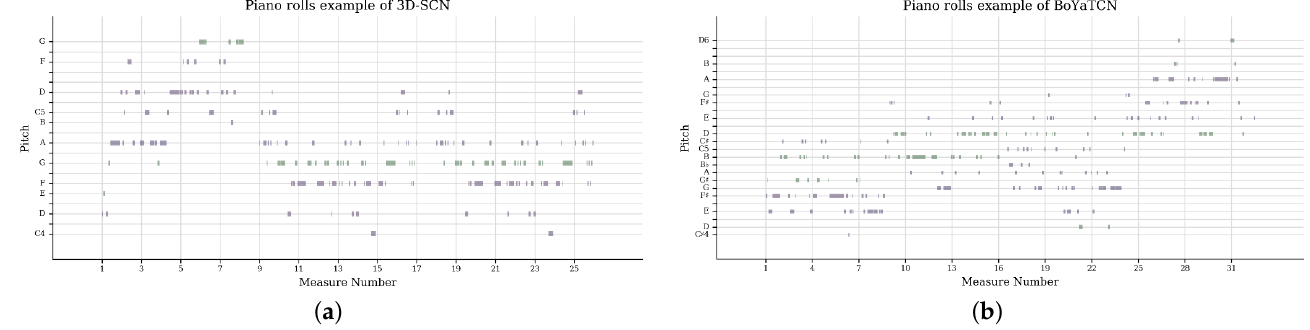
Figure 17. Fragment of a piano roll of a random pentatonic scale music sample from 3D-SCN ( a ) and BoYaTCN ( b ). Table 6. Evaluation of randomly generated music by music professionals and